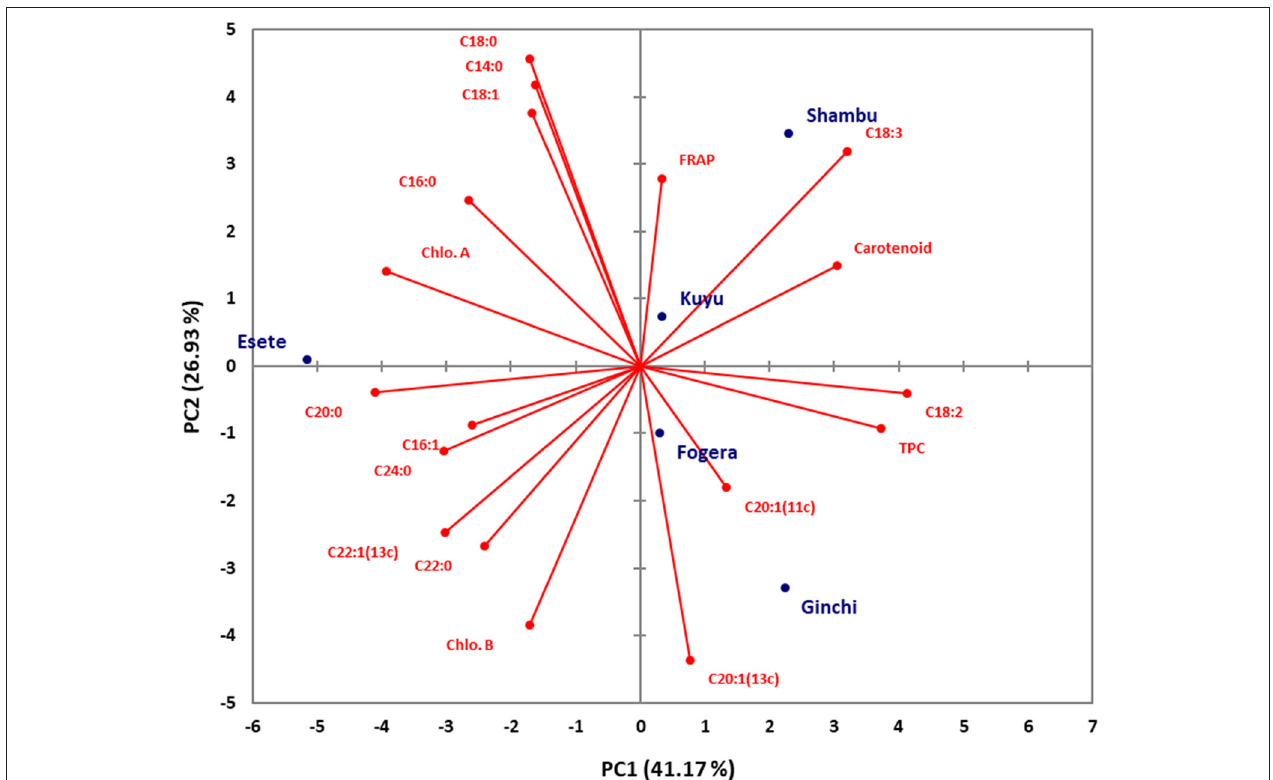
FIGURE 3 | Score plot of principal component analysis (PCA) for the combined data sets of fatty acid composition, total phenolic, carotenoid, and chlorophyll contents and their antioxidant properties for the niger seed